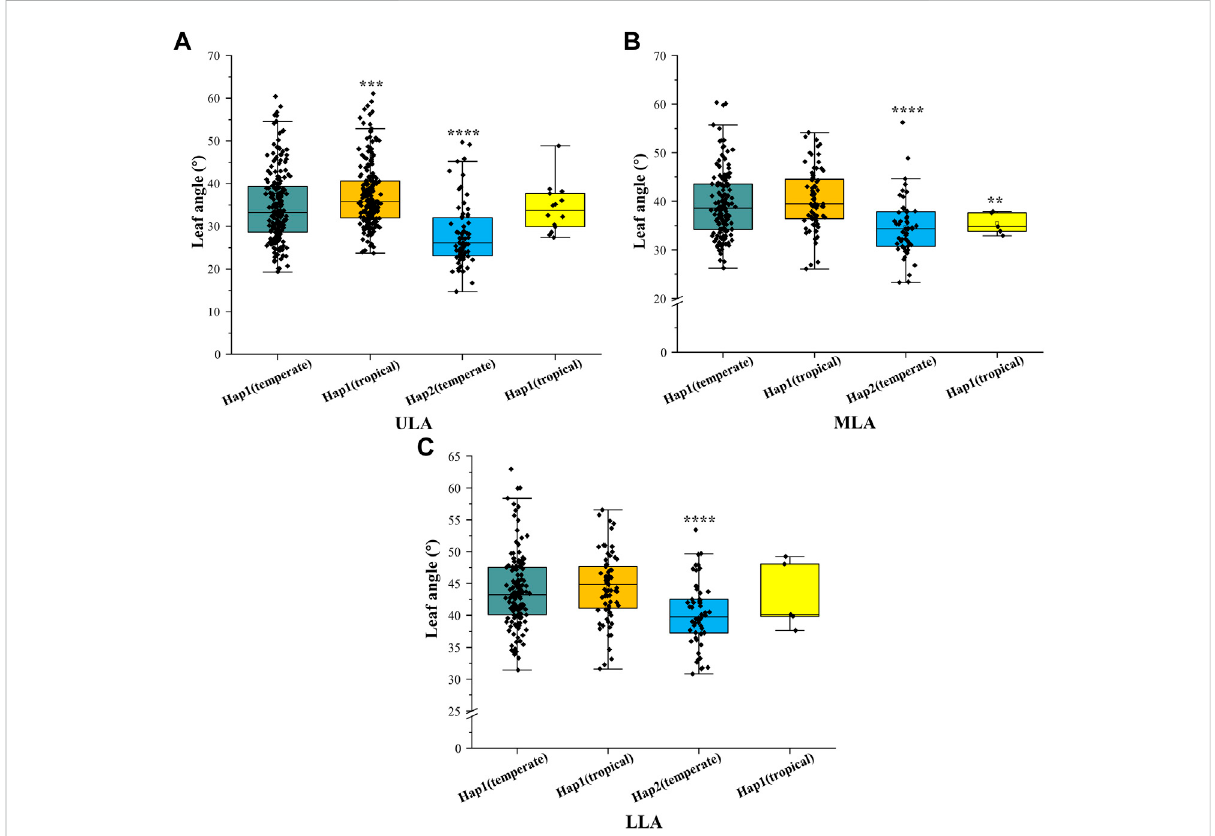
FIGURE 7 DifferencesinLA-relatedtraitsbetweenHap1(temperate),Hap1(tropical),Hap2(temperate),andHap2(tropical). (A) ULA. (B) MLA. (C) (LLA).The signi fi cance level was obtained by comparing others haplotypes with Hap1(temperate), respectively. *: p < 0.05, **: p < 0.01, ***: p < 0.001, ****: p < 0.0001, not marked stands for not signi fi